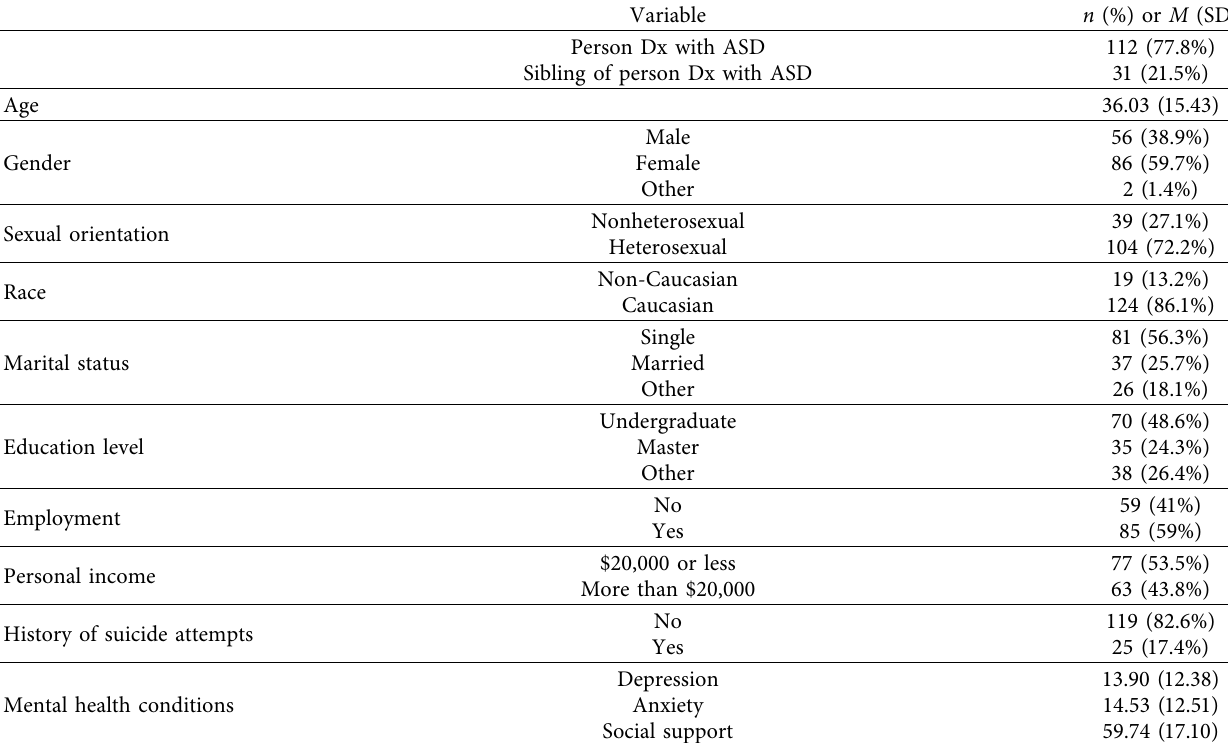
Table 1: Demographic characteristics of the sample ( N �